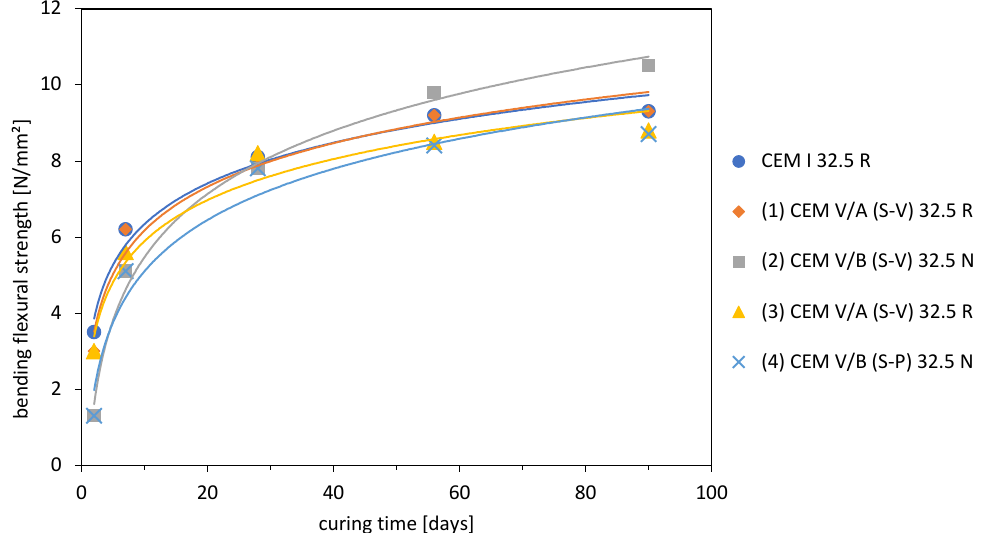
Figure 5. Bending flexural strength development of standard mortar prisms according to [51] (each value as mean value of 3 individual tests), after 2, 7, 28, 56, and 90 days.